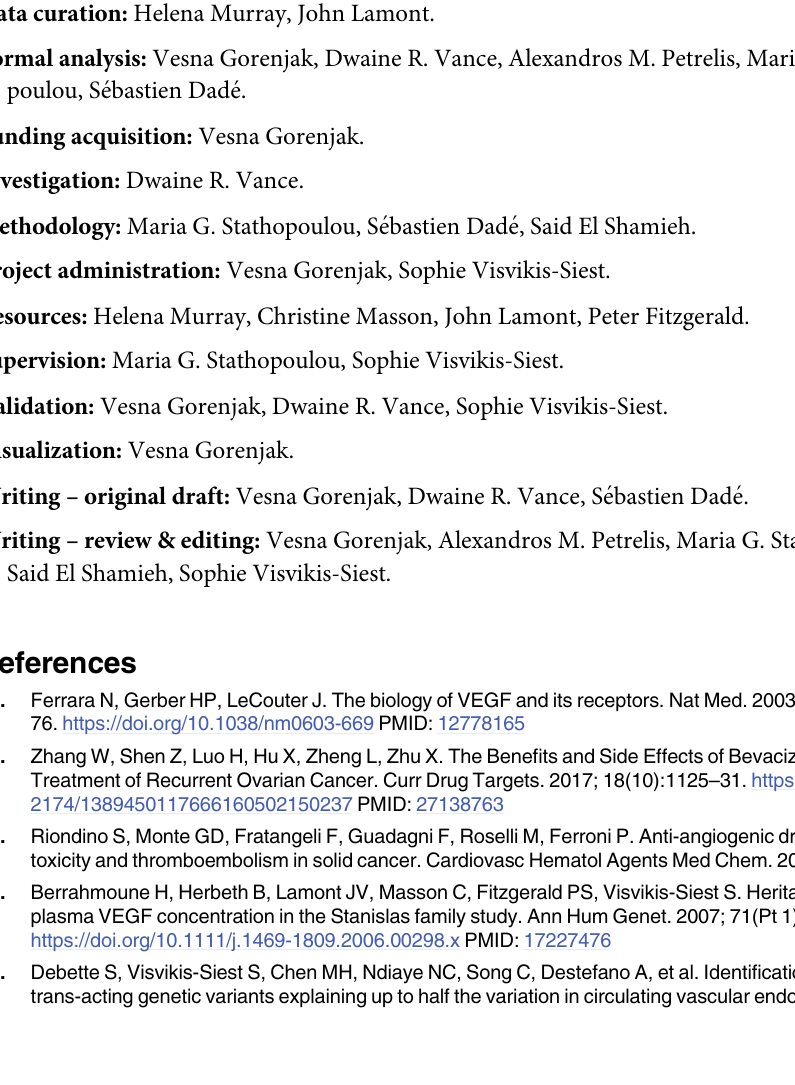
S1 Table. Primer sequences for quantification of VEGF